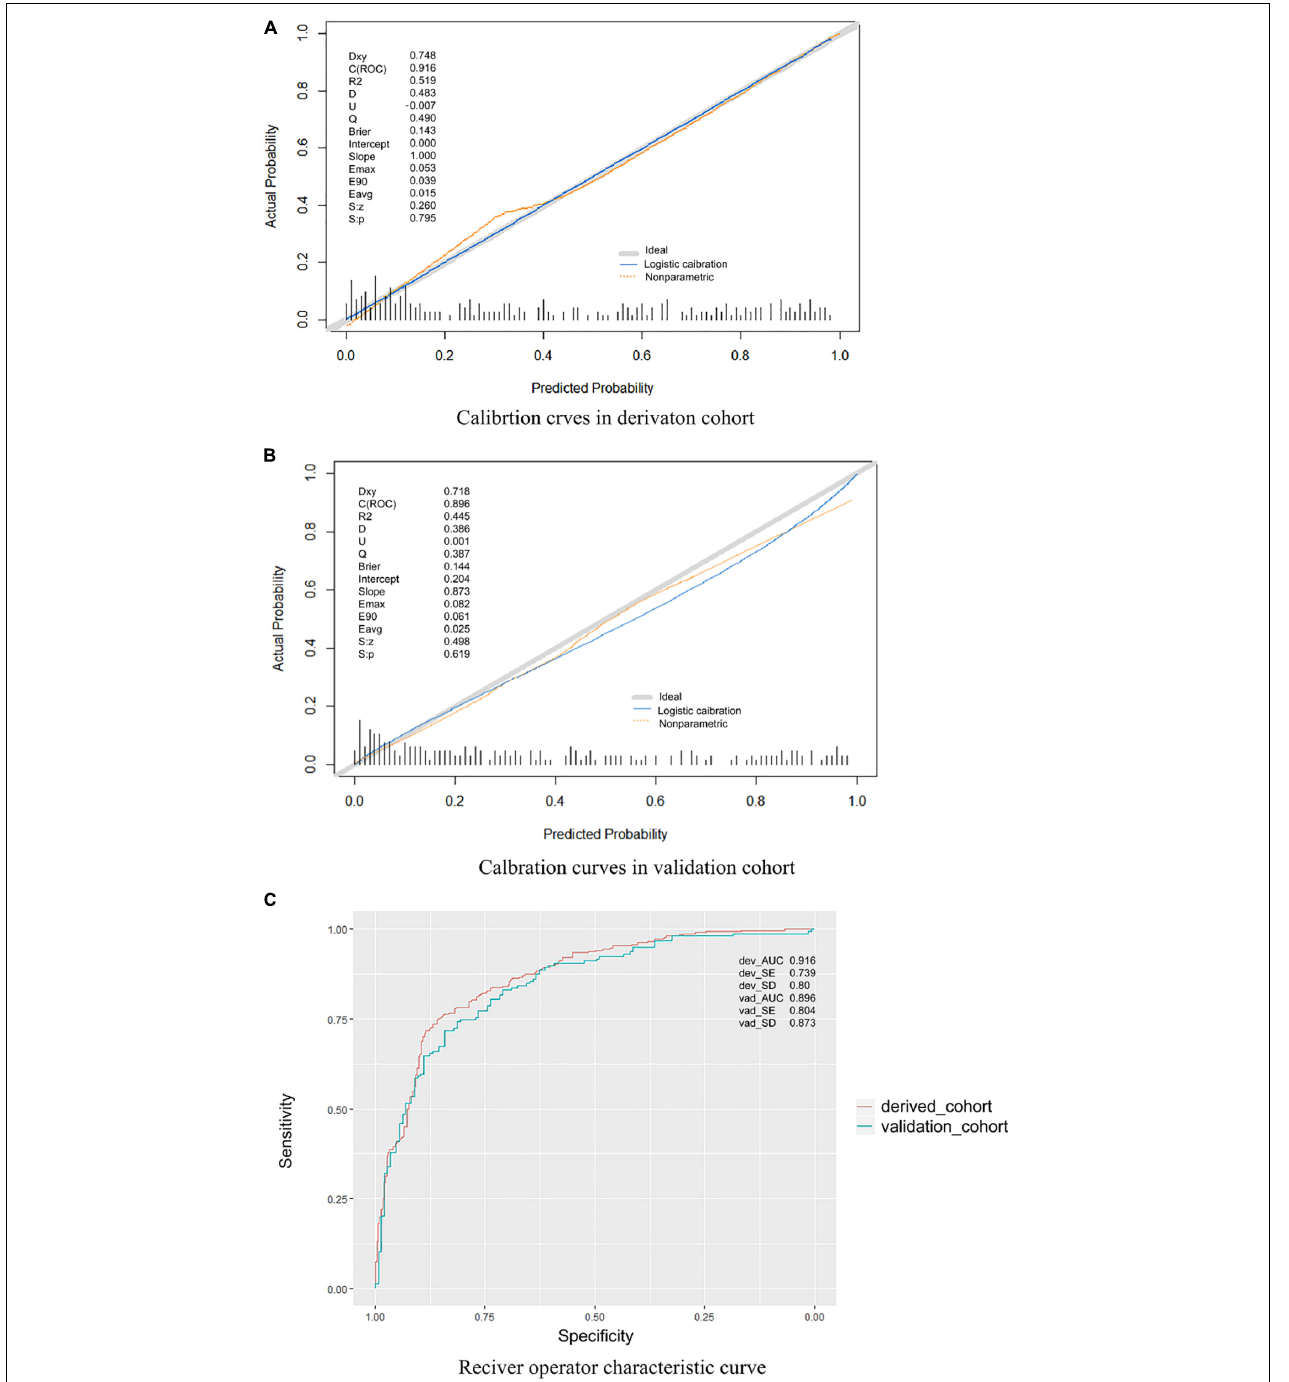
FIGURE 3 | (A) Calibration curves in the derivation cohort. (B) Calibration curves in the validation cohort. The calibration curve was drawn based on the consistency between the prediction and the label. The y -axis represents the actual results, and the x -axis represents the predicted results. Diagonal lines represent perfect predictions of the ideal models. Solid lines represent the performance of the model, and a closer fit to the dotted diagonal line indicates better prediction. The ideal model is a perfectly fitting curve, where the predicted probability is equal to the actual probability. The non-parametric part is the calibration result obtained by fitting the sample data through non-parametric regression, which is a built-in fitting method of the R software. The logistic calibration is the calibration result obtained by the fitting method used to construct our model. Dxy, Somer D rank correlation; R 2 , Nagelkerke–Cox–Snell–Maddala–Magee R 2 index; D , discrimination index; U, unreliability index; Q, quality index; Emax, maximum absolute difference in predicted and calibrated probabilities; S: z , Spiegelhalter Z test; S: p , two-tailed p -value of the Spiegelhalter Z test. (C) Receiver operating characteristic curve. This model had an area under the receiver operating characteristic curve of 0.916 in the derivation cohort and 0.896 in the validation